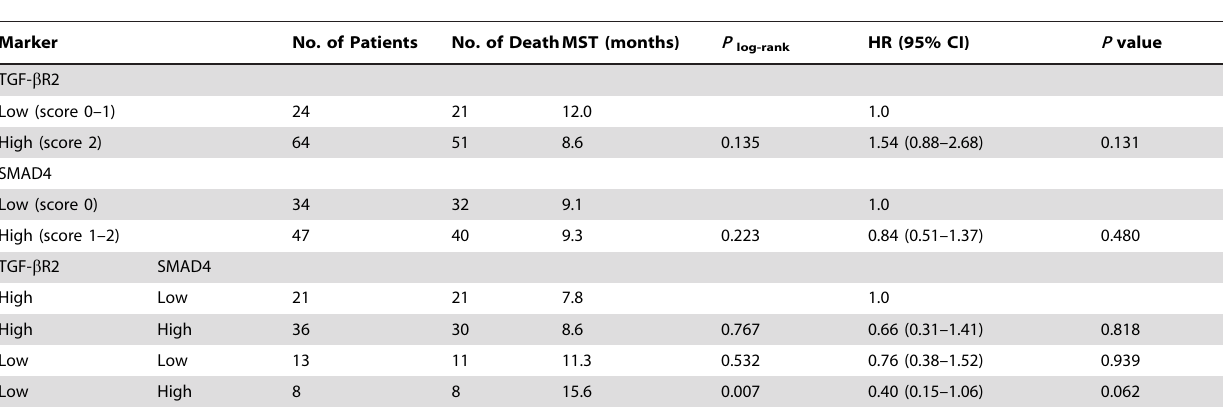
Table 2. Nuclear staining for TGF- b R2 and SMAD4 and association with overall survival.